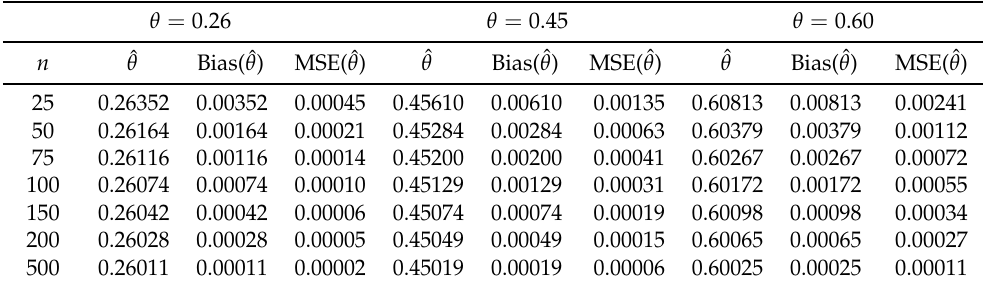
Table 1. Simulation results: MLEs, bias, and MSE. θ = 0.26 θ =